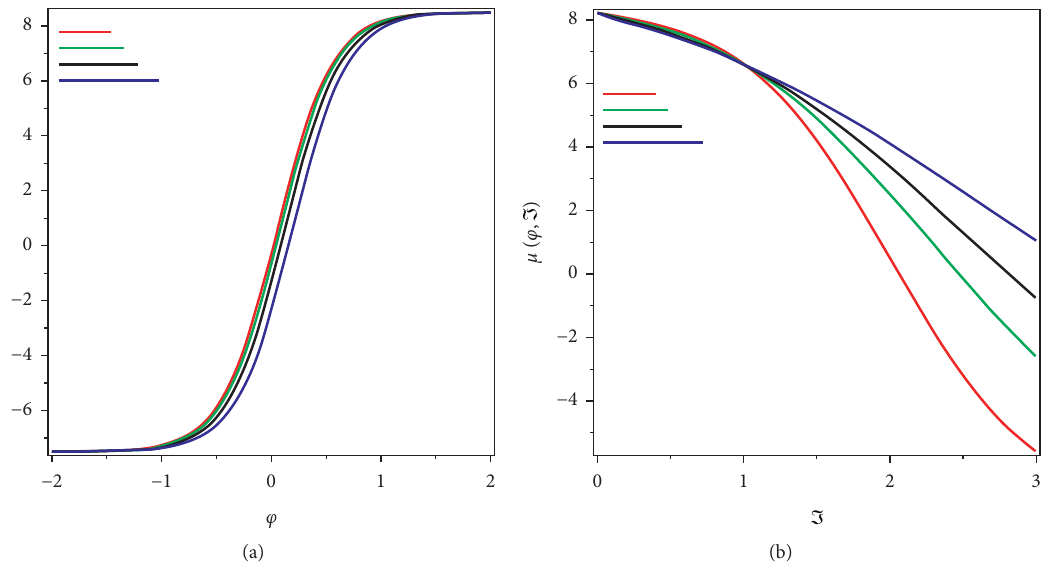
Figure 7: The different fractional-order solution with respect to the Atangana–Baleanu operator of μ ( φ , I ) at β of Example